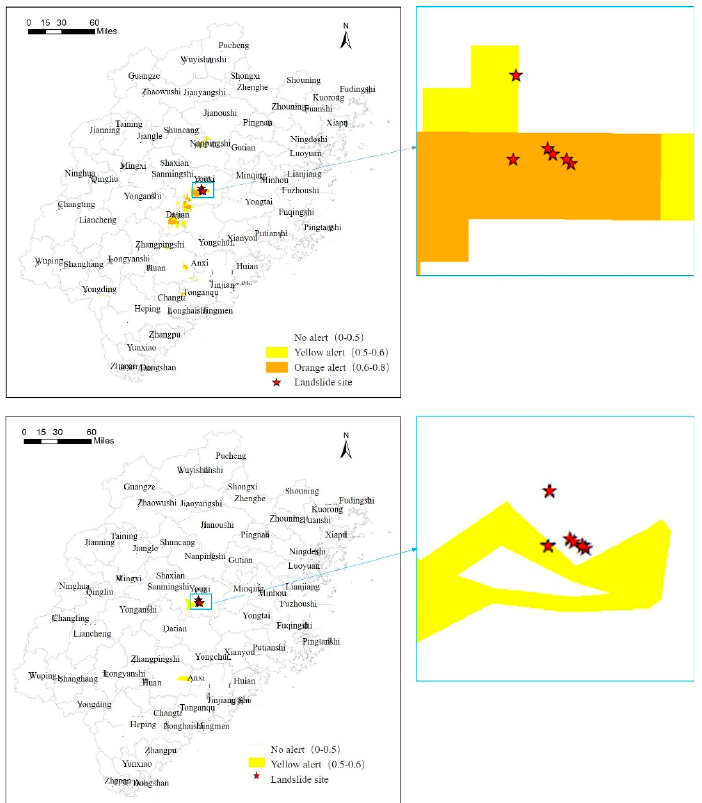
Figure 10. Comparison of early-warning results of different models on 22 June 2021 (above: early-warning results of the Random Forest model; below: explicit statistical model warning results). According to the comparison on 28 June 2021 (Table 6, Figure 11), four landslide dis- asters all fell in the early-warning area (orange warning area) of the Random Forest model, with a hit rate of 100%; four landslides fell in the warning zone of the explicit statistical model (two yellow warning areas), the hit rate is also 100%. The landslide densities in the early-warning areas of the two models were 1.7 and 1.0 per 1000 square kilometers, re- spectively. The actual landslide density in the early-warning area of the Random Forest model was 1.7 times that of the explicit statistical model. Table 6. Comparison between the Random Forest model and explicit statistical early-warning model.